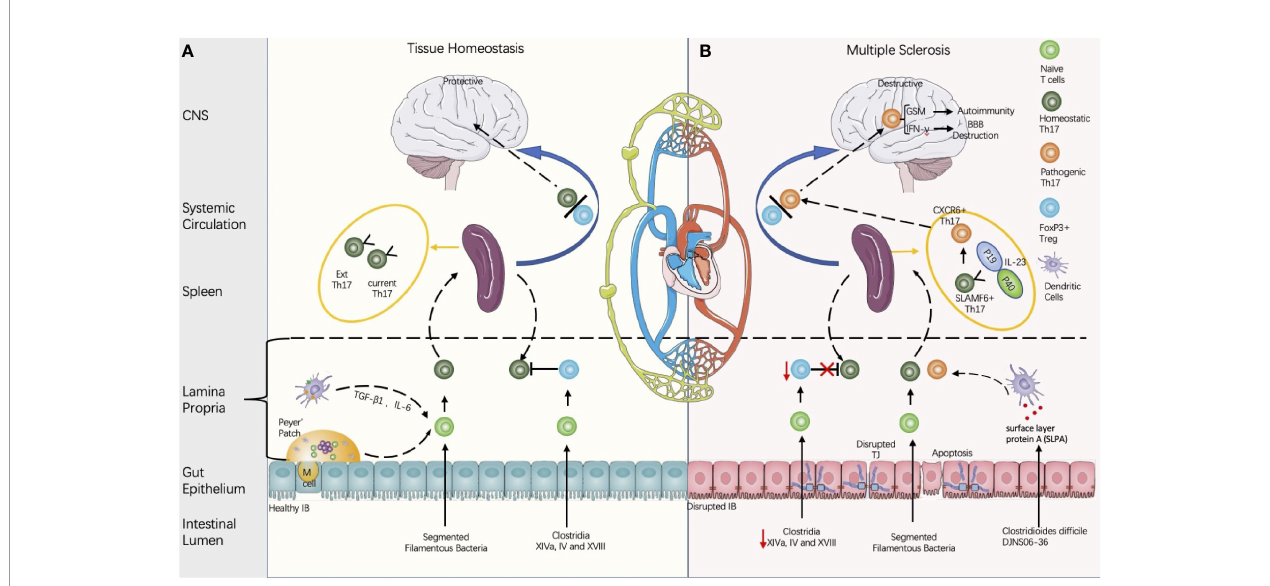
FIGURE 2 | Proposed model of multiple sclerosis initiation derived from the gut microbiota regulated by balance between the Th 17 cells and the regulatory T cells (Th17/Treg). (A) Composition of the gut microbiota in fl uences the intestinal barrier (IB) integrity and the Th17/Treg balance. Intestinal Th17 could be induced by segmented fi lamentous bacteria (SFB), and the contact between the SFB and intestinal epithelial cells is a pre-requirement for Th17 induction (Atarashi in 2015). Meanwhile, CD4+FOXP3+ Treg could be induced either by Clusters XIVa, IV, and XVIII and their 17 strain (93), or by metabolites produced by gut microbiota. Th17 cells is heterogenous and can be classi fi ed into current Th17 and Ex Th17. Under homeostatic status, FoxP3+ Tregs restrains the Th17 within protective roles. (B) In disease conditions, the decreases of Clostridium clusters XIVa and IV are associated with the Th17/Treg imbalance and IB disruption. Some strains of Clostridioides dif fi cile contain cross-reactive fragments in their surface layer protein A (SLPA), which is like the epitopes of myelin basic protein (94). In vitro experiments demonstrated their potential to induce pathogenic Th17 (94). In the EAE model, stem-like SLAMF6+ Th17 in spleen can be induced by IL-23 and differentiate into CXCR6+ Th17 with homing speci fi city to the brain; CXCR6+ Th17 is pathogenic by secretion of the proin fl ammatory factors with potential to destruct BBB (IL-17A, IFN- g ) and to induce autoimmunity (GSM)